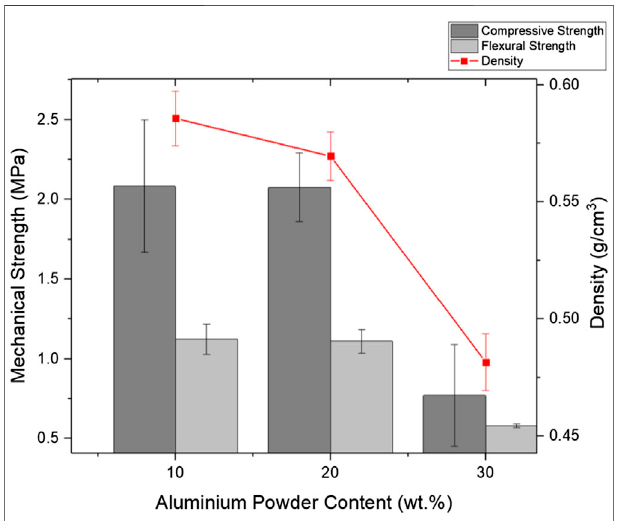
FIGURE 6 | Effect of aluminum powder content on the mechanical performance and density of foamed alkali-activated glass cured for 7 days.